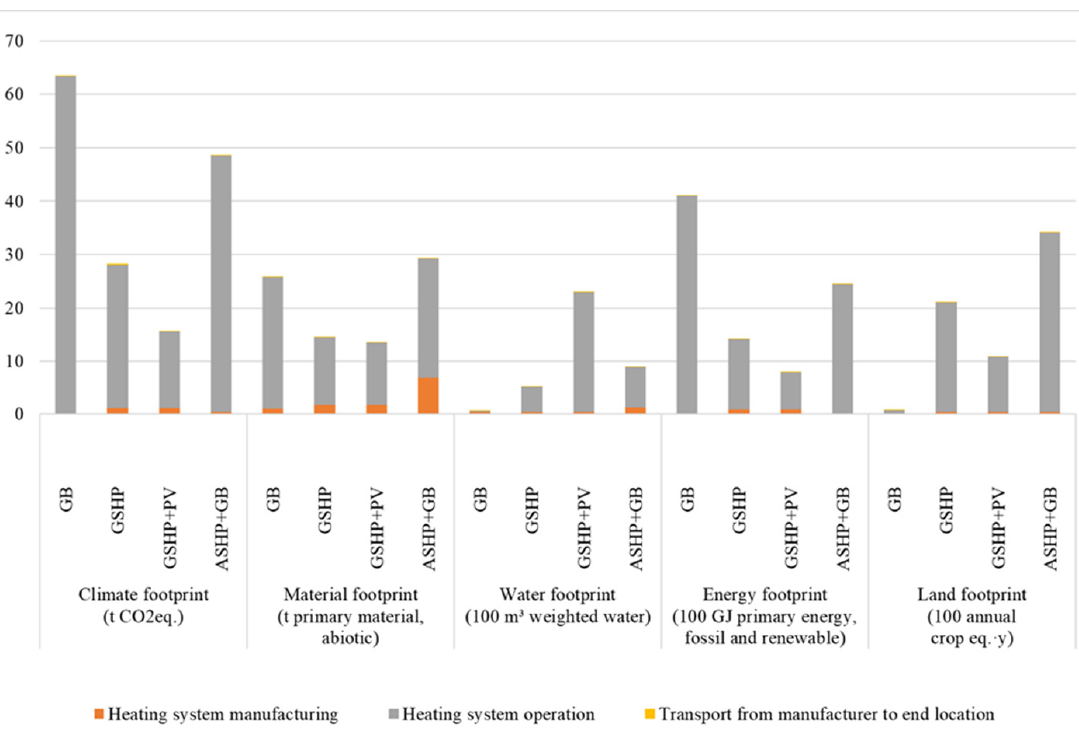
Figure 5. Resource and climate footprints of the four heating systems per final energy for the whole building in MWh per year. The results for manufacturing and transport were applied to the entire service life of 50 years. The material footprint is represented by the Total Material Requirement (TMR). Notes. GB: Gas boiler, GSHP: Ground ‐ source heat pump, GSHP + PV: Ground ‐ source heat pump with a photovoltaic system, ASHP + GB: Air ‐ source heat pump backed up with a gas boiler. The results show that the operation phase mostly contributes to the footprints of the heat generation system. Transport of the system from the manufacturer to the end ‐ user location causes almost negligible footprints in comparison to the other life ‐ cycle phases.